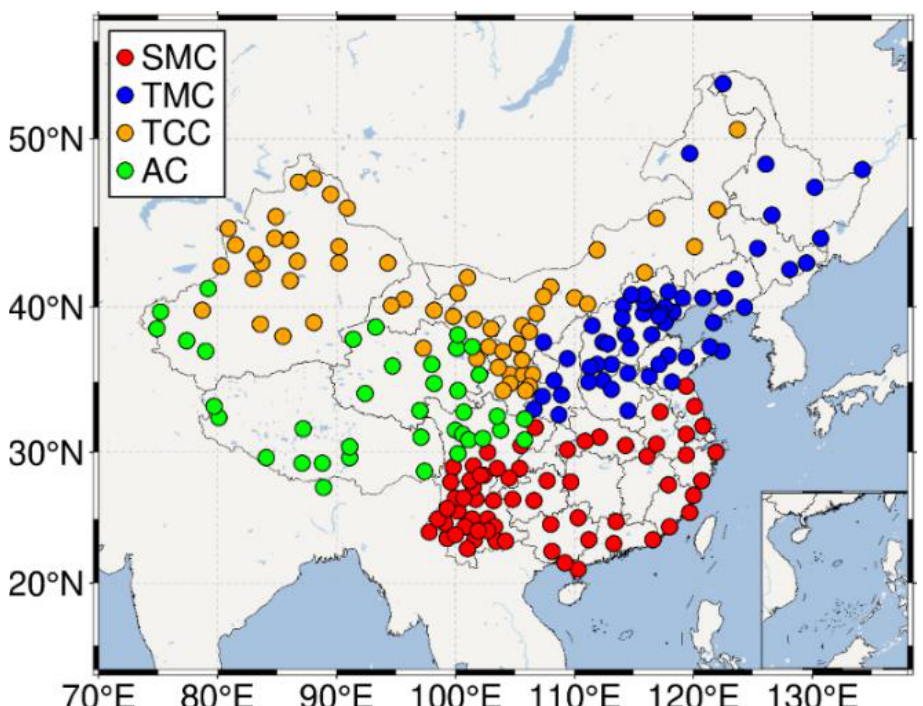
Figure 1. Geographical distribution of Crustal Movement Observation Network of China (CMONOC) GNSS stations in different climate types. SMC represents the subtropical monsoon climate region, TMC represents the temperate monsoon climate region, TCC represents the temperate continental climate region, and AC represents the plateau mountain climate region.